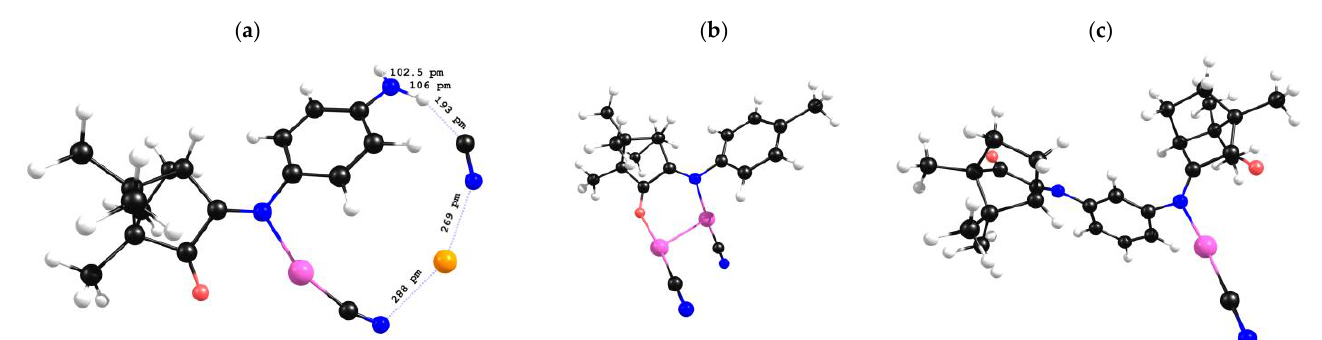
Figure 1. DFT optimized structure for complexes: ( a ) 1 , ( b ) 6, and ( c ) 13 .